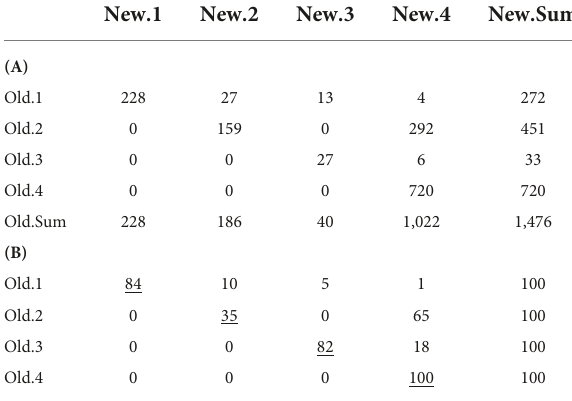
TABLE 1 Total of 1,476 products in Mintel category “Instant Noodles” in